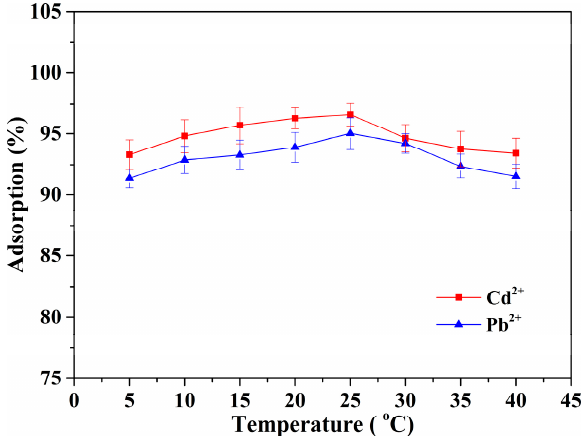
Figure 7. Effect of temperature on metal ion adsorption (100 mg of Alg-EDTA was added to 50 mL 1.5 mM of Cd 2+ (or Pb 2+ ) solution at different temperatures).